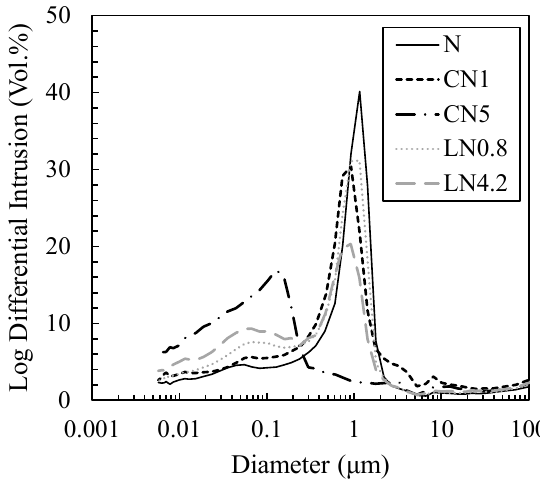
Figure 11. Void size distribution (1 day).